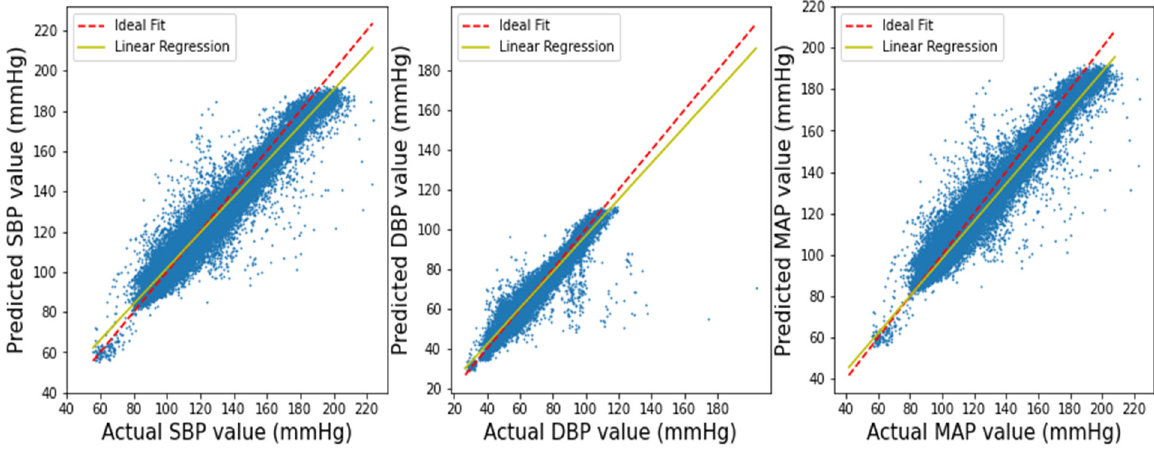
Figure 7. Linear regression plot for SBP, DBP, and MAP results.